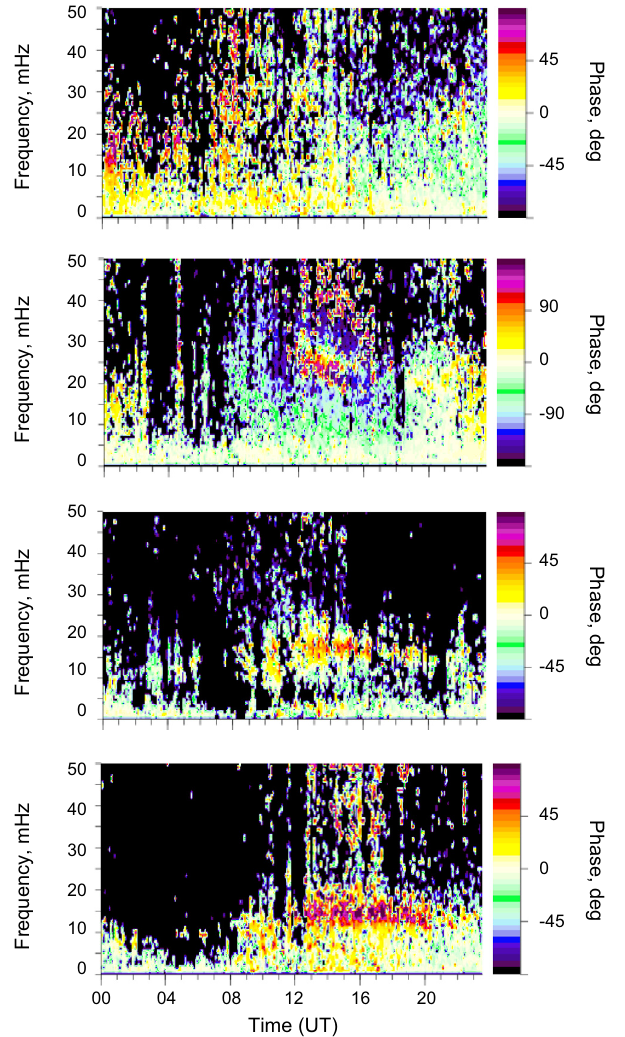
Fig. 3. Whole-day cross-phase spectra for L = 2.61 Antarctic Peninsula stations for (top to bottom) 11, 15, 17 and 20 December 2003, respectively. Colour scale represents cross-phase magnitude and sign between the stations; note the different scale for 15 December. Horizontal cross-phase bands identify the resonant frequency.